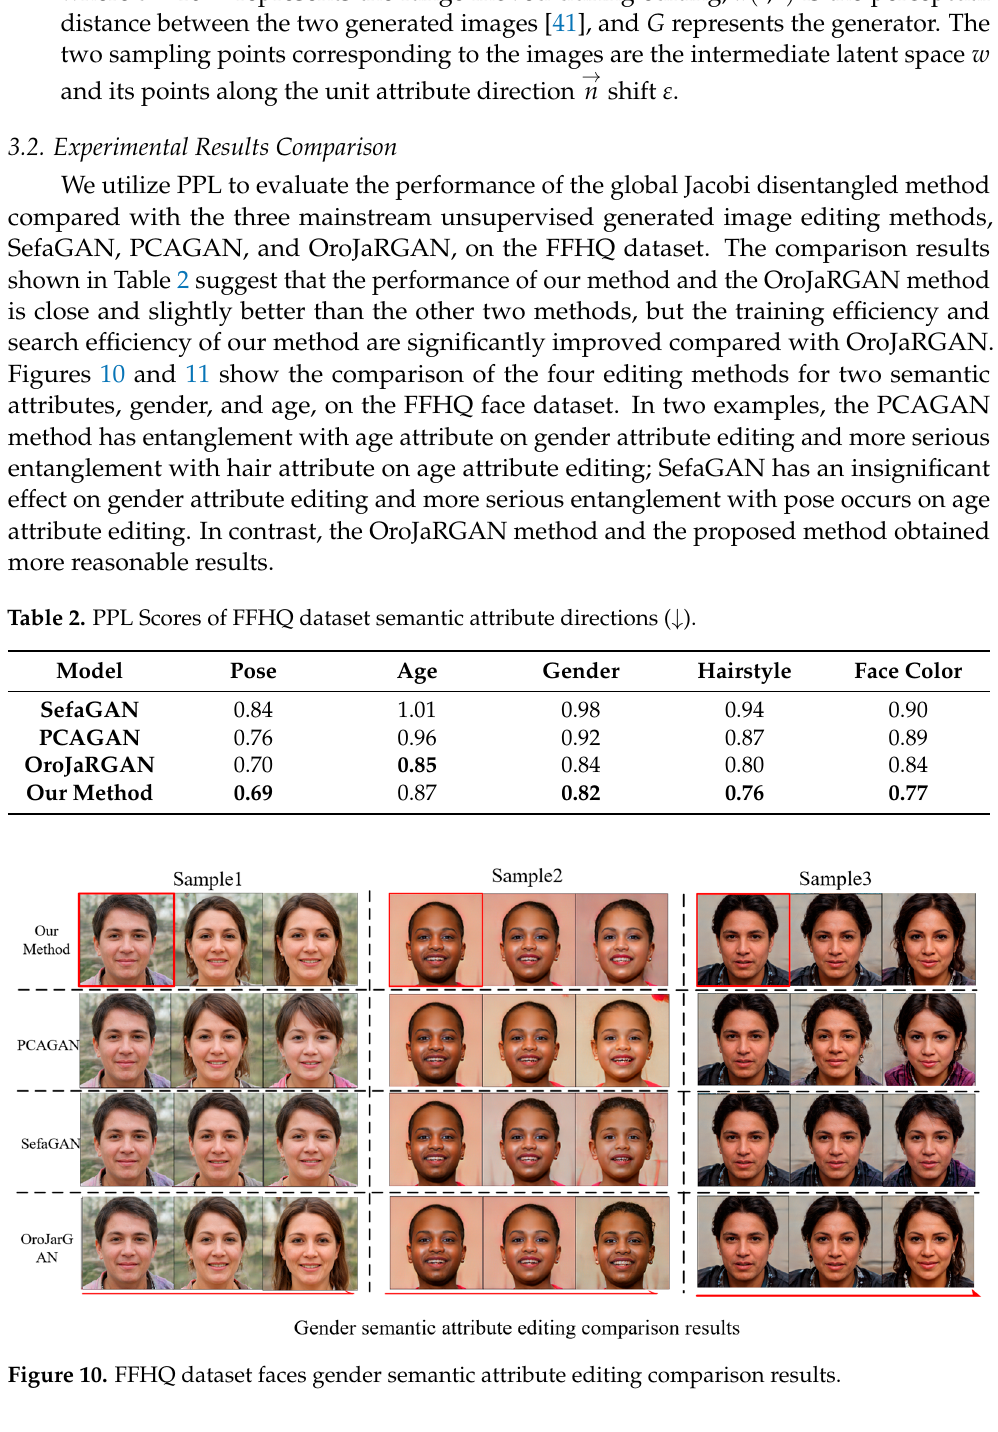
Figure 11. FFHQ dataset faces age semantic attribute editing comparison results. We evaluated four methods on the LSUNCat dataset in the same way, and the results are shown in Table 3. The disentangled performance of this method is similar to OroJaR- GAN and better than PCAGAN and SefaGAN. We compared the results of semantic at- tribute editing for rotation and cat coat color, and the results are shown in Figures 12 and 13. In both examples, PCAGAN and SefaGAN are more severely entangled with the cat poses in rotation semantic attributes, and more severely entangled with the global color in cat coat color, compared with these two methods in this paper. The editing effect of our method is significantly improved. Our method is similar to OroJaRGAN in terms of PPL metrics because the search method is the same, only the semantic direction is initialized in a different way. Referring to papers [42,43], the equivalent model of SefaGAN considered only that the role of the mapping function in the network is limited to the style layer, ignoring the role of other layers. the effect of PCAGAN depends heavily on the number of sampling points. In con- trast, our method resembles an end-to-end form when computing the Jacobi matrix with- out the problems of the two methods above. So, our method has an improvement in the PPL metric.